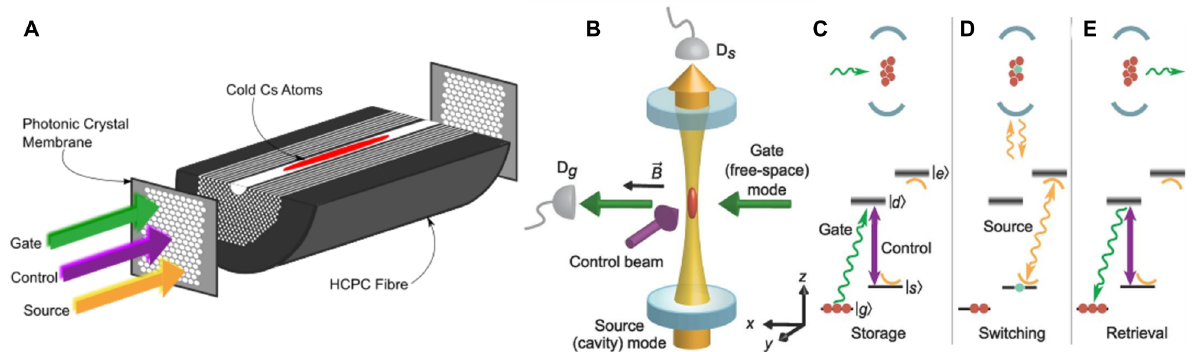
Fig. 15. (A) A HCPC fiber cavity using PC membranes as mirrors in which the source, probe and pump light may be sent along the axis of the cold atom cloud to increase light–matter interactions. (B) Experimental setup of Chen et al. [77] for a single photon all-optical switch. (C–E) The optical scheme is shown, in which the gate photon is first stored in the atomic excitation to state | s ⟩ , which results in a blockage of the source light through the cavity. The gate photon can then be retrieved by ramping up the control field (Source: